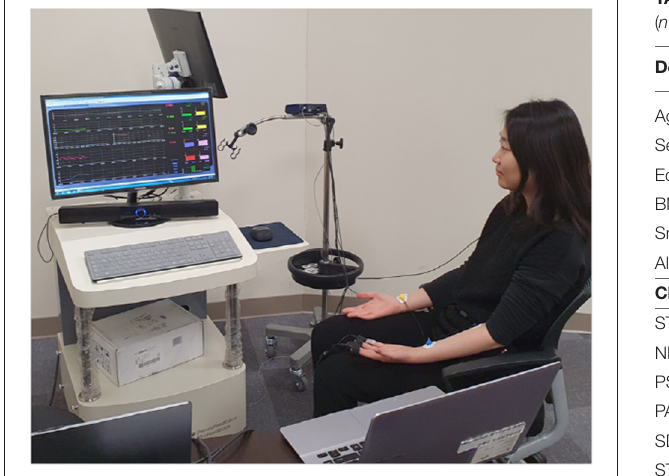
FIGURE 5 | Snapshot of biofeedback session.